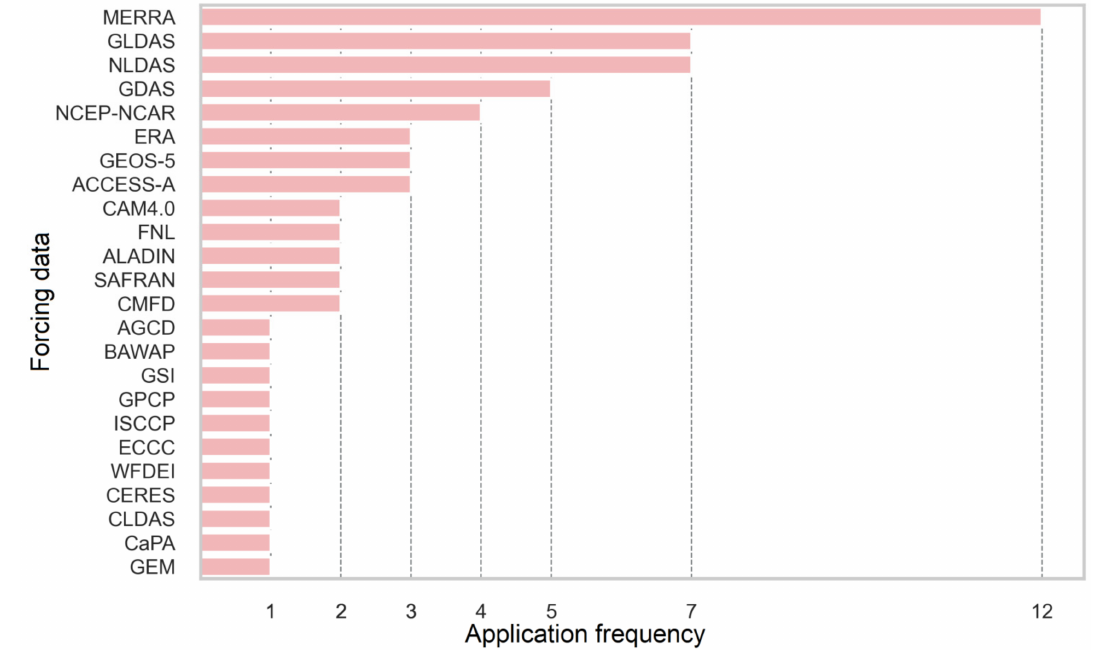
Figure 4. The application frequency (count) of different forcing data for assimilating SM in LSMs in the reviewed